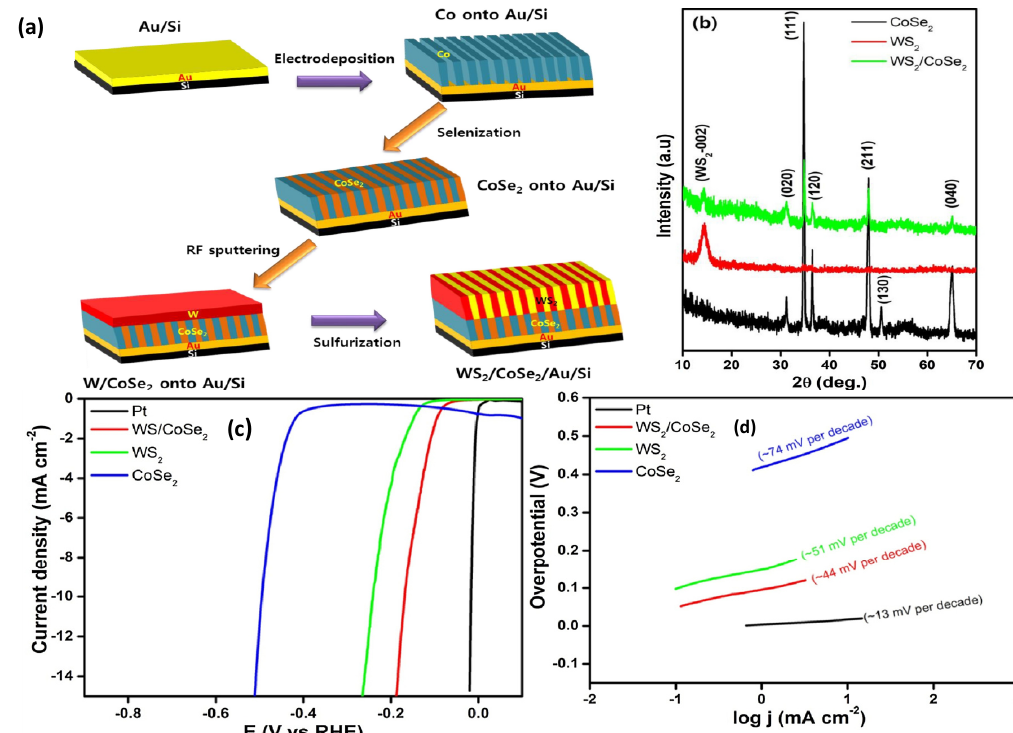
Figure 9. ( a ) Schematic illustration of the synthesis of the WS 2 /CoSe 2 /Au/Si heterostructure. ( b ) XRD pattern of CoSe 2 , WS 2 , and CoSe 2 /WS 2 heterostructures. ( c , d ) LSV and Tafel curves of the WS 2 /CoSe 2 heterostructure in comparison with the pristine materials, respectively. Reproduced with permission [143]. Copyright 2018, Elsevier.